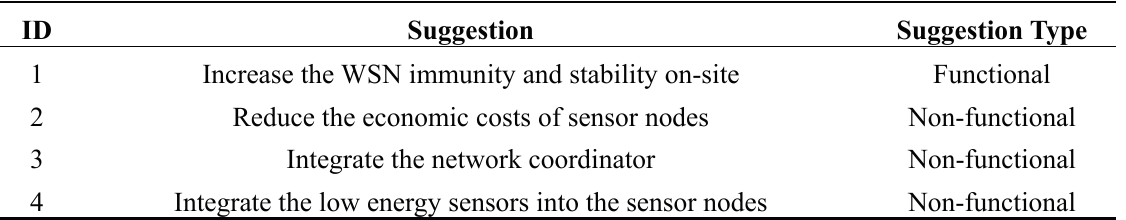
Table 5. Suggestions for the improvement and perfection of